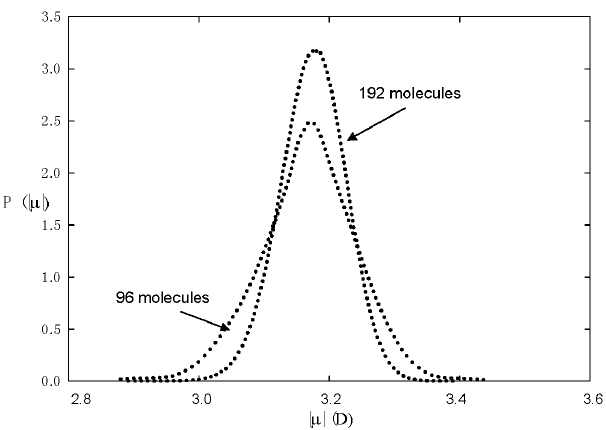
Figure 4. Probability distribution of the molecular dipole moment for DRSLL ice I h